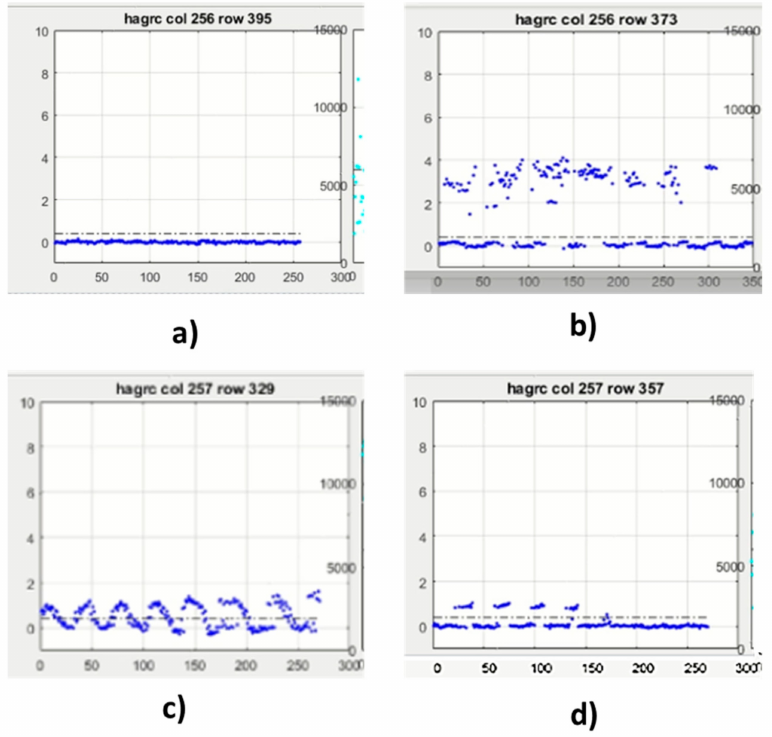
Figure 12. ( a ) Roads, ( b ) trees, ( c ) shrubs, and ( d ) cars in a parking lot identified in LiDAR